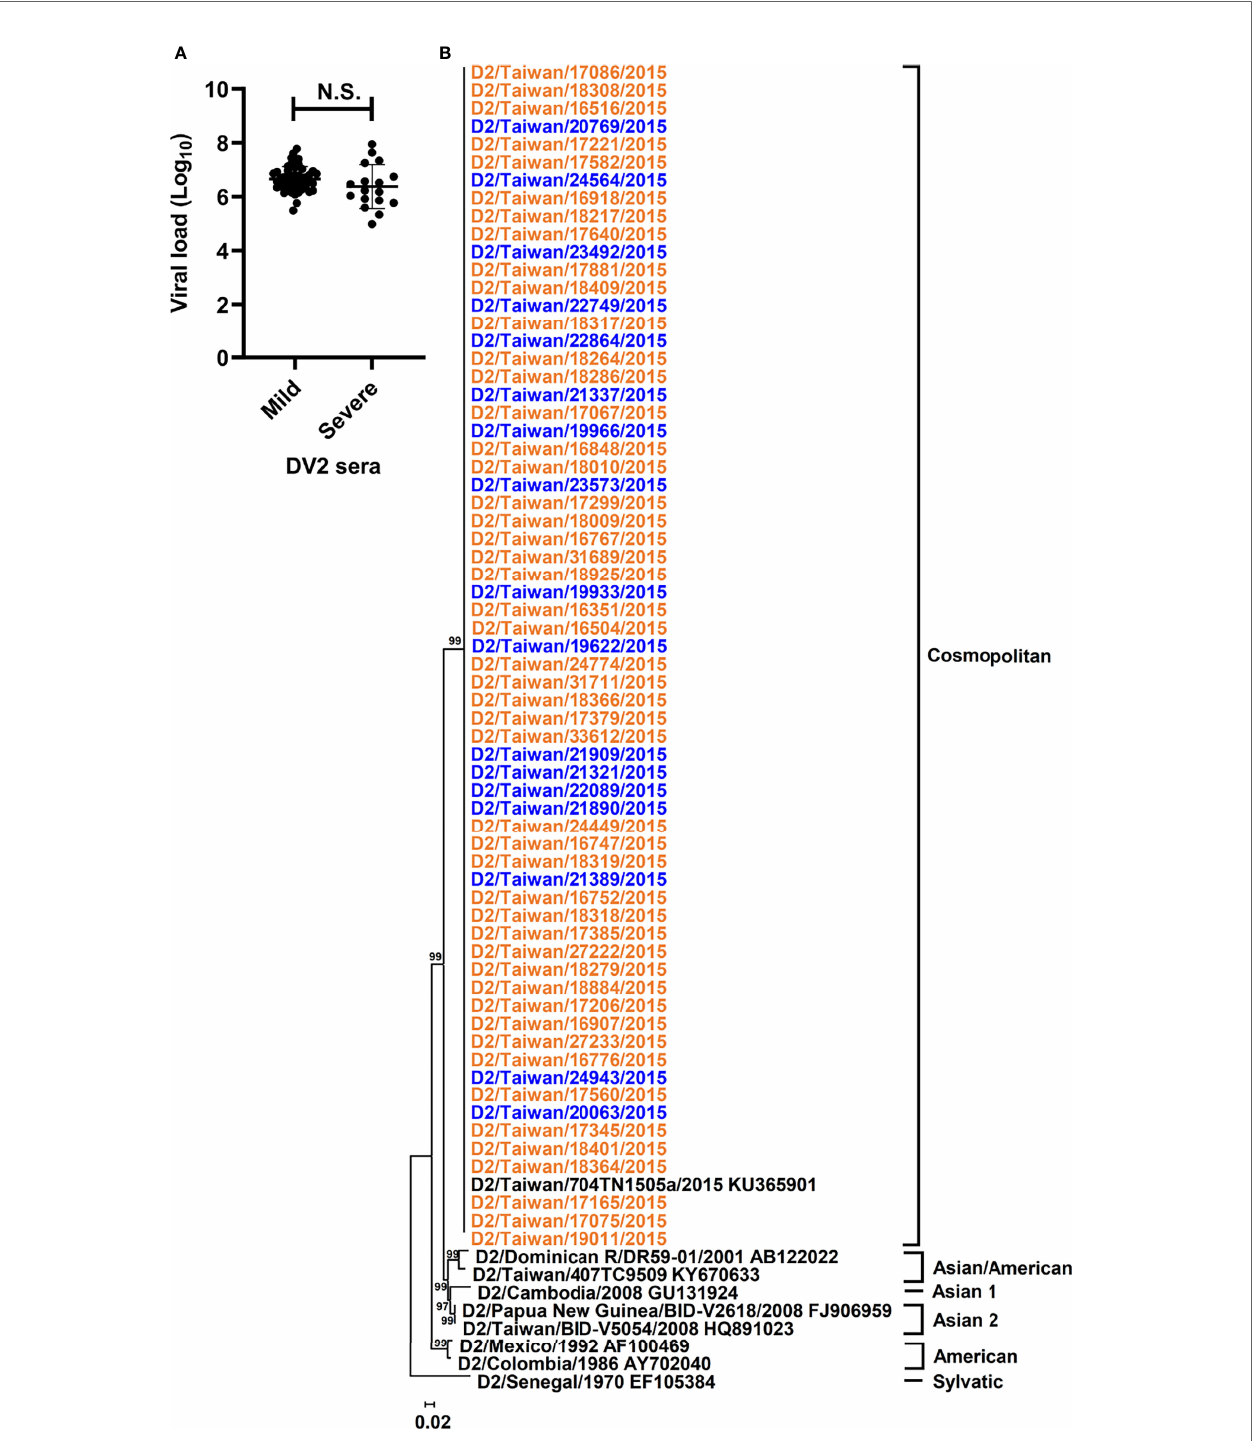
FIGURE 1 | Viral loads and phylogeny of DENV-2 sequences from patients with different disease severity. Viral loads and phylogeny of viral consensus sequences from DENV-2 patients with diverse disease outcomes were displayed. (A) The viral loads in the sera of DENV-2 infected patients with mild and severe disease were compared. N.S. indicated p > 0.05 in Mann-Whitney U test. (B) Consensus sequences of polyprotein coding region from the sera of enrolled DENV-2 patients and those of DENV-2 prototypes were analyzed using the maximum likelihood method with 1000 bootstrap replicates. Sequences from mild cases (orange) and severe cases (blue) were indicated by different colors and clustered into 6 genotypes, including Sylvatic, American, Asian 1, Asian 2, Asian/American, and Cosmopolitan genotypes. The bootstrap values of each genotype were indicated at the root of the